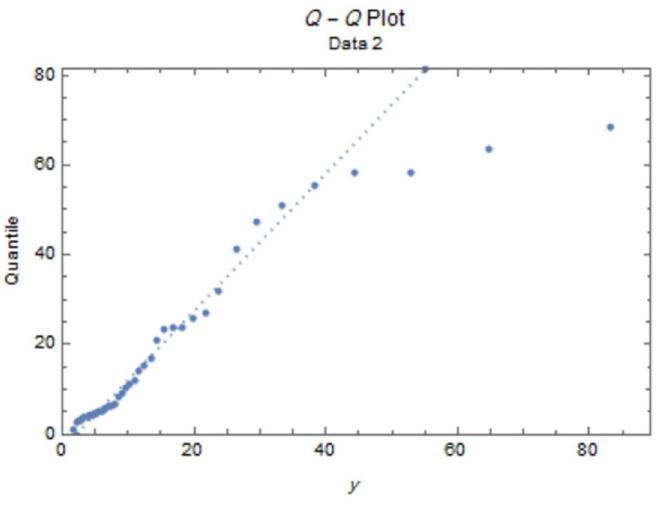
Fig 13. Q-Q plot for data 2.